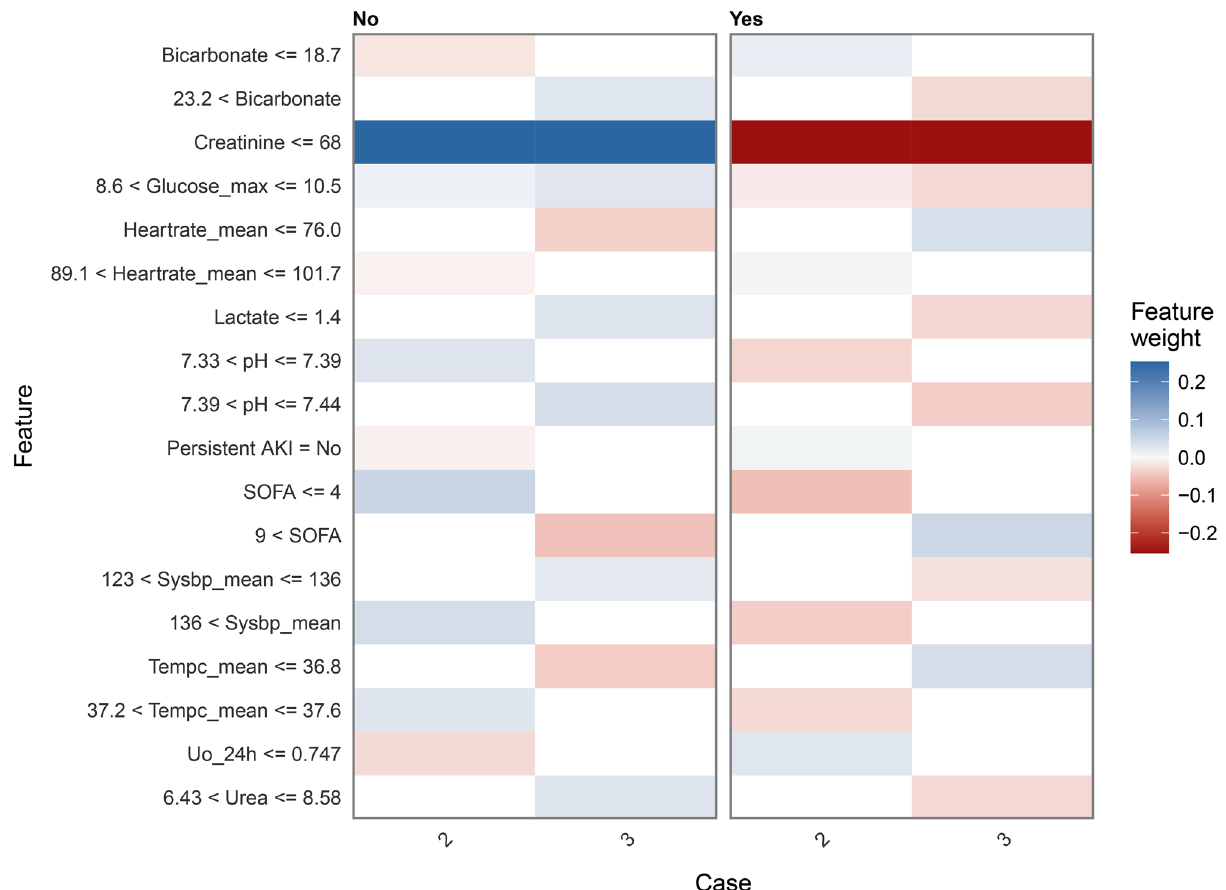
Figure 5. Heatmap plot showing the contribution of each variable to the classification of the sample patients. The relative contribution of each variable was calculated using the LIME algorithm. Data of patients 2 and 3 are shown as examples. The red colour indicates that the relevant variable contradicts a given label, while the blue colour indicates support. AKI, acute kidney injury; SOFA, Sepsis-related Organ Failure Assessment; Uo_24h, Urine volume for 24 h on intensive care unit admission; LIME, Local Interpretable Model-Agnostic